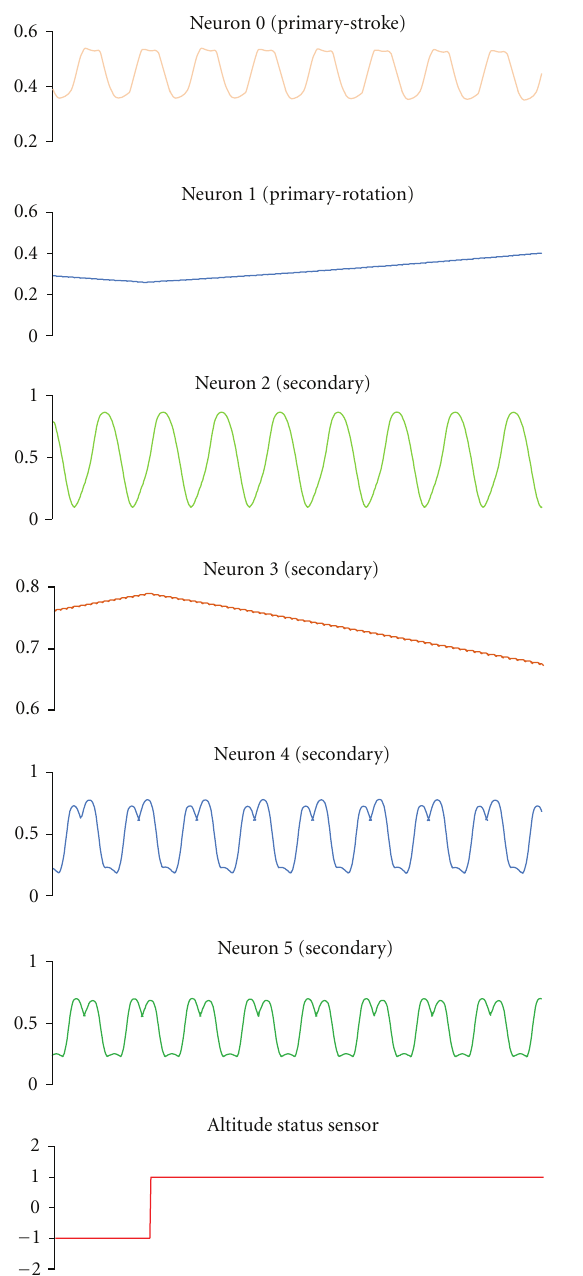
Figure 26: The above figure shows the neuron output state dynam- ics of each neuron in the reduced six neuron architecture of the cruise controller architecture shown in Figure 22. It can be noticed that the qualitative output dynamics of each neuron do not di ff er significantly from their original behavior shown in Figure 23. More- over, It can be observed that the output states of neuron 1 and 3 entrain with altitude sensor in phase and out of phase, respectively.